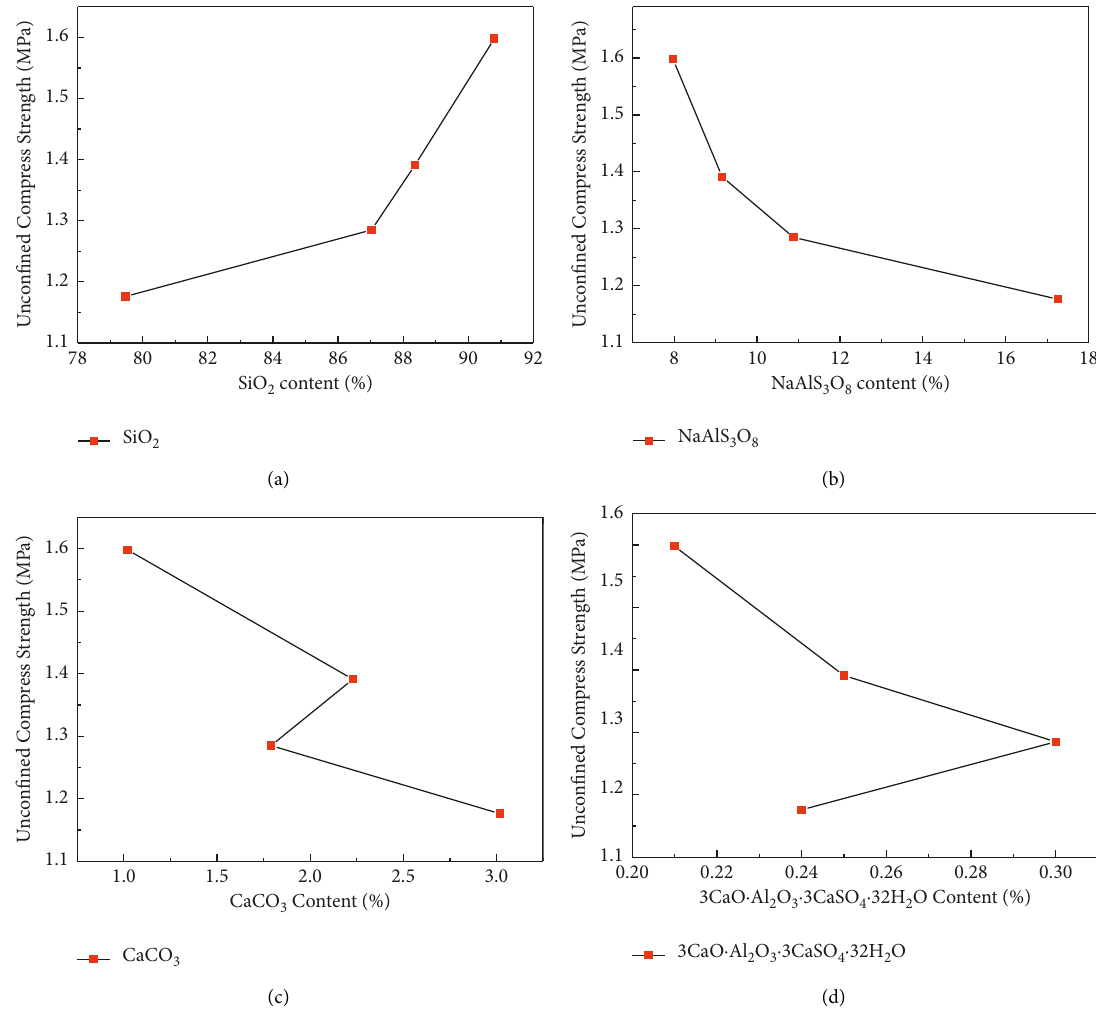
Figure 9: Relationship between the phase content and unconfined compressive strength. (a) Quartz. (b) Albite. (c) Calcite. (d) Ettringite.